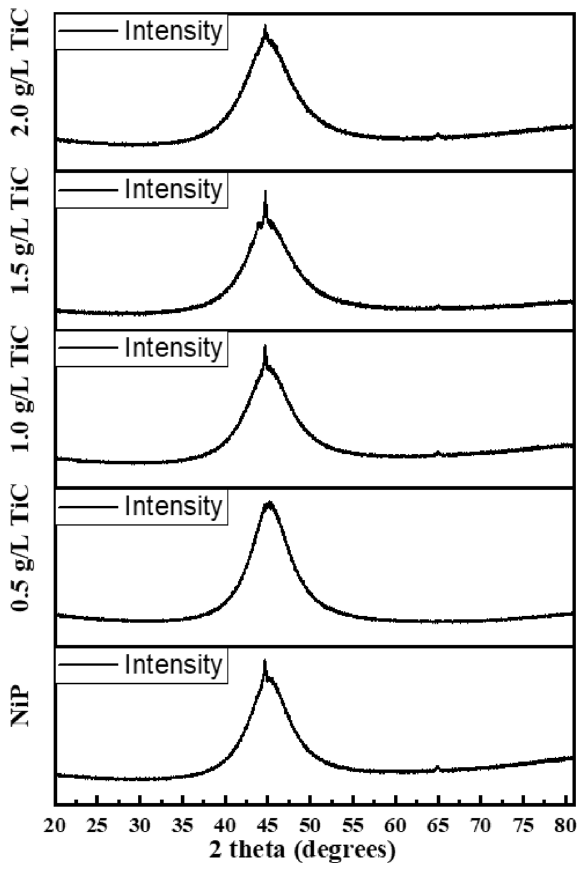
Figure 2. XRD spectra of Ni–P and Ni–P–TiC composite coatings containing various concentrations of TiC particles.